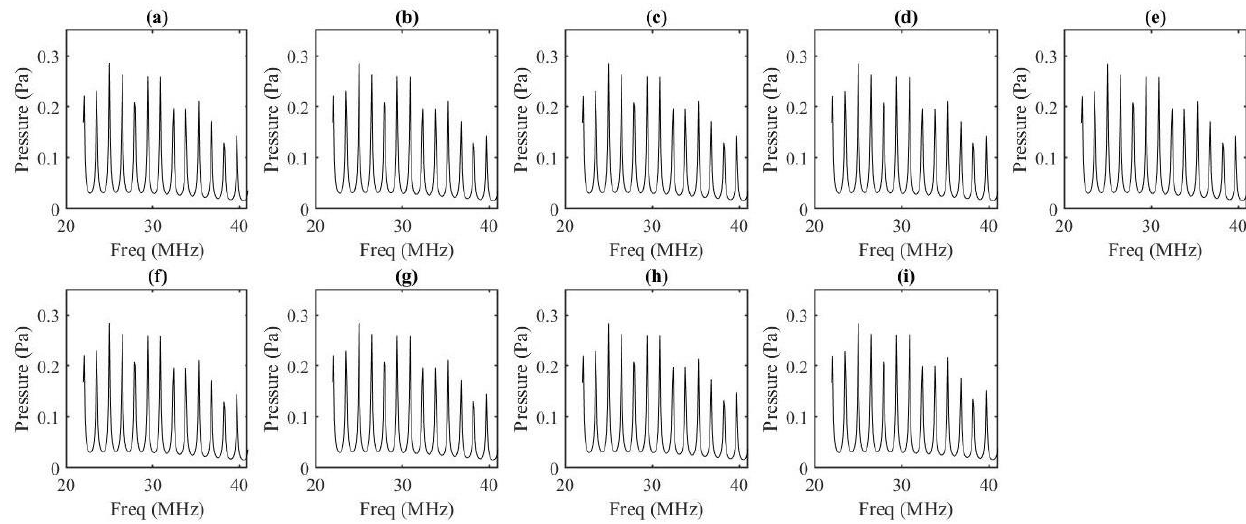
Figure 10. Frequency spectrum in Sector 3 for flake positioned at ( a ) − 2 mm, ( b ) − 1.5 mm, ( c ) − 1 mm, ( d ) − 0.5 mm, ( e ) 0 mm, ( f ) 0.5 mm, ( g ) 1 mm, ( h ) 1.5 mm, and ( i ) 2 mm.